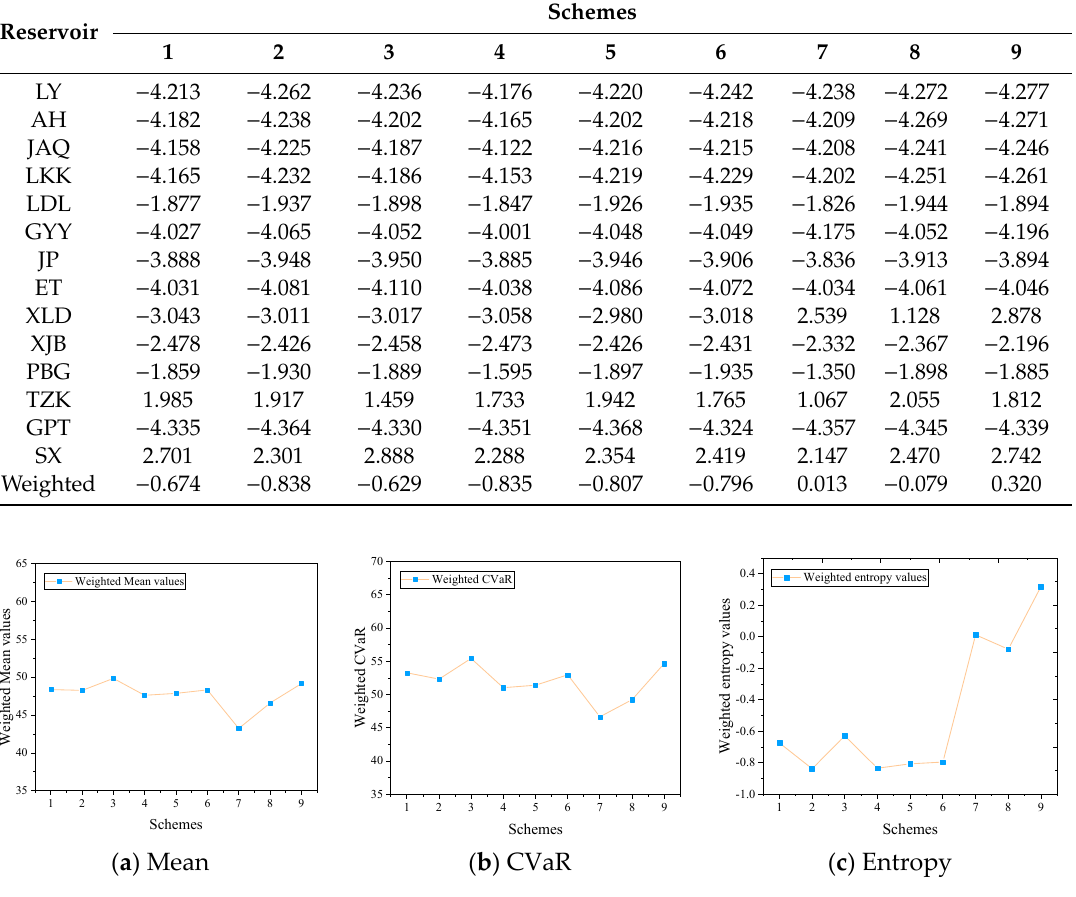
Figure 4. Weighted risk indicators.